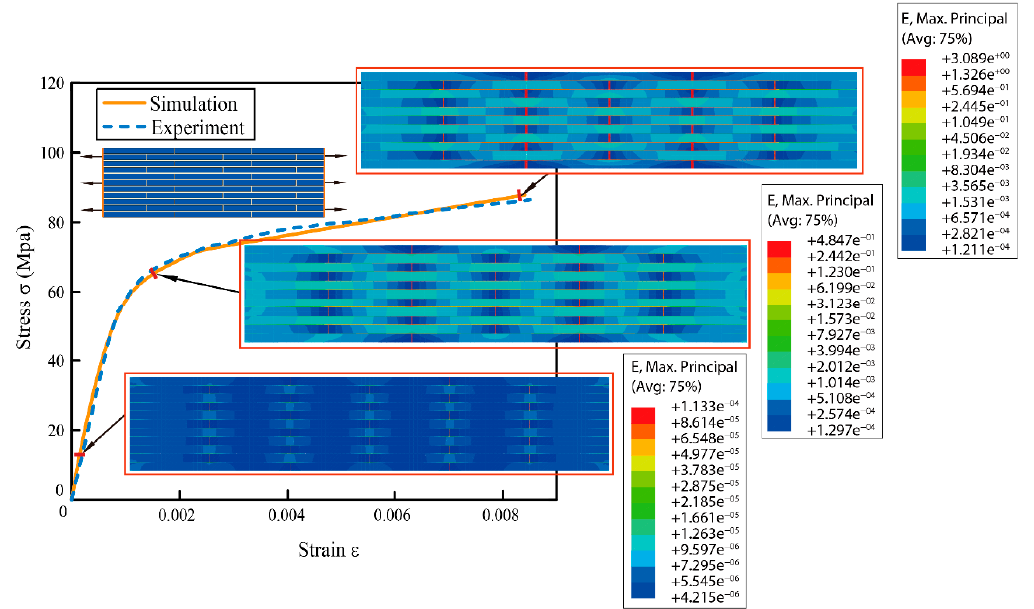
Figure 3. Comparison of the experimental results in the references and the simulation results of the current finite element model. The inset figures depicted snapshots of the strain in the model at 10 MPa, 65 MPa, and 85 MPa stresses,